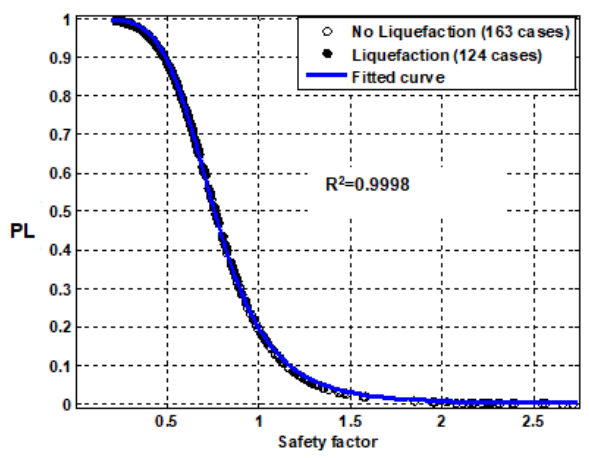
and Fs based on Bayesian L